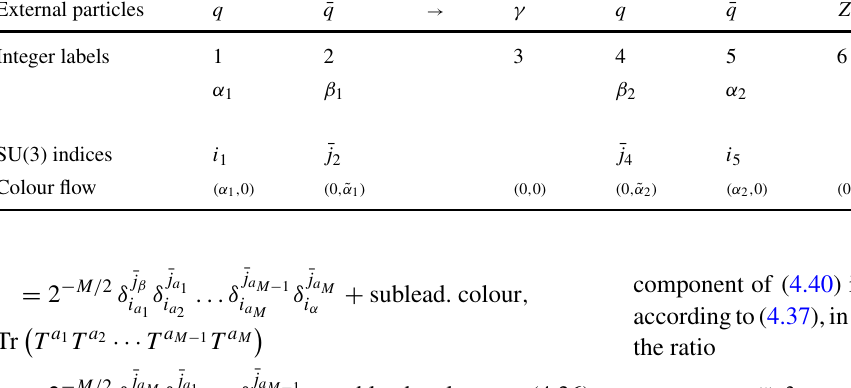
Table 7 Particle and colour numbering scheme. The external particles are labelled through consecutive integers 1 , 2 ,..., N p according to the ordering (4.1) specified through the process registration. The symbols σ k are used in (4.26)–(4.29) to represent the integer labels of exter- nal gluons, while a σ are the corresponding colour indices. Similarly, k α (β ) represent the integer labels of incoming quarks (antiquarks) k l or outgoing antiquarks (quarks), and their colour indices are i α